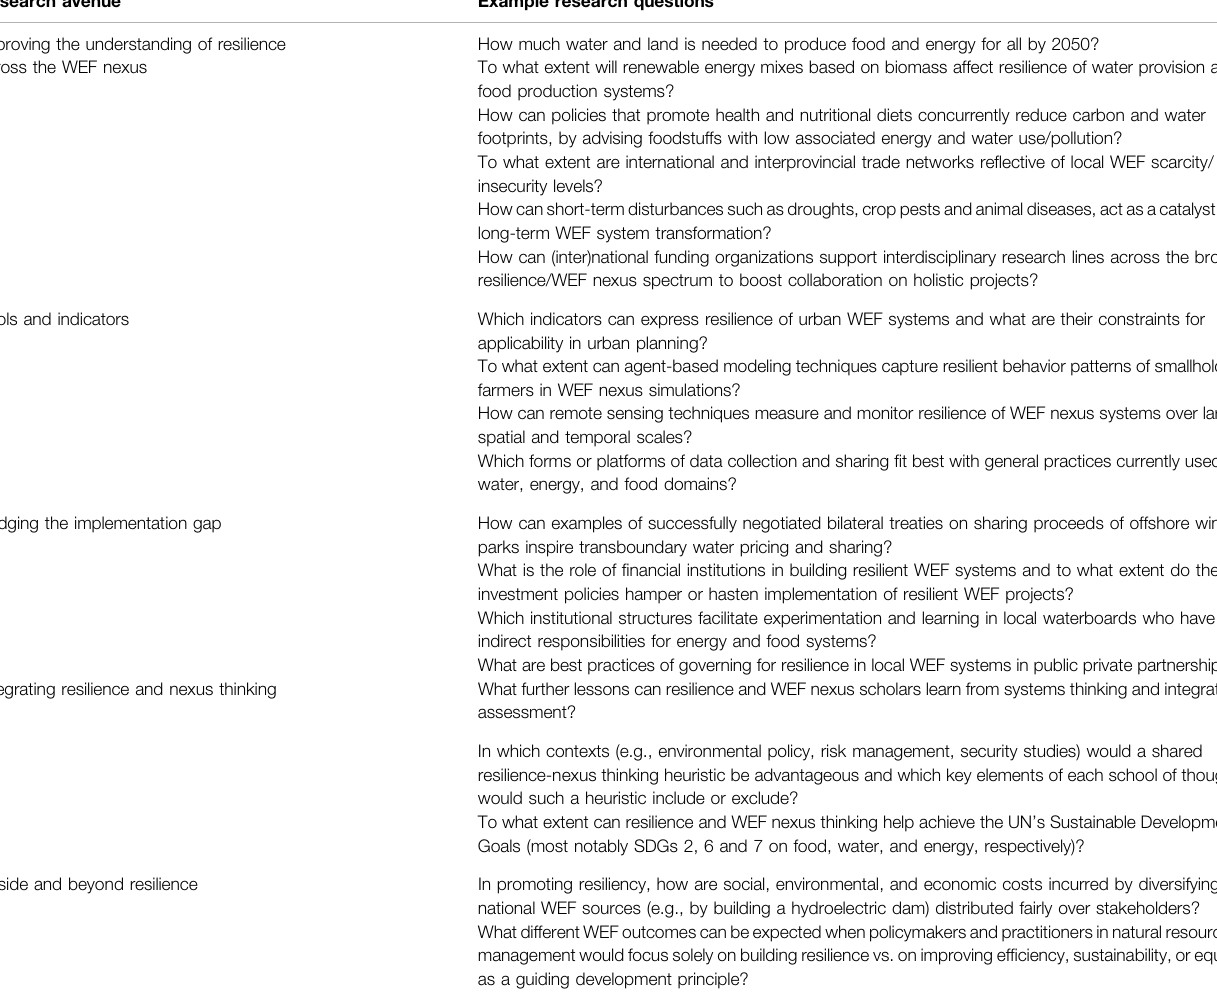
TABLE 2 | Overview of example research questions per identi fi ed research